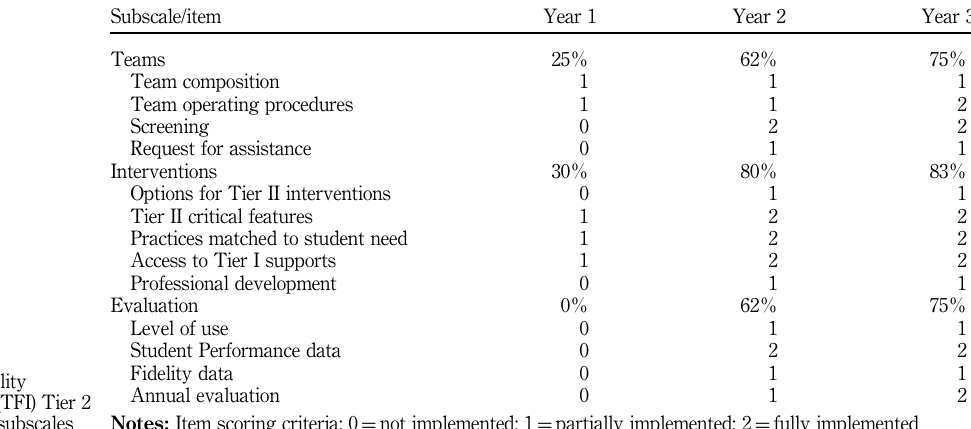
Table II. Tiered fidelity inventory (TFI) Tier 2 items and